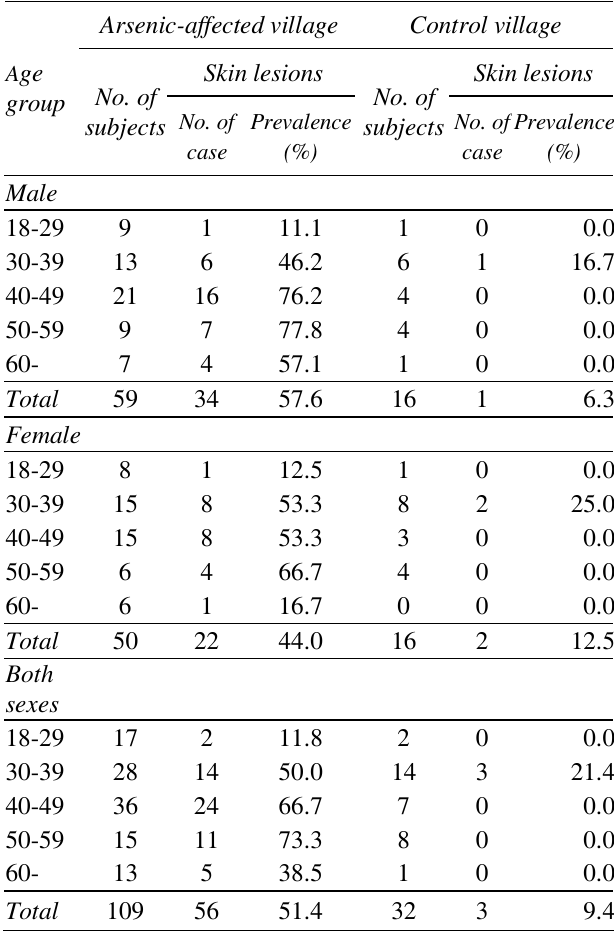
Table 2: Distribution of the prevalence of skin lesions by sex and age group among